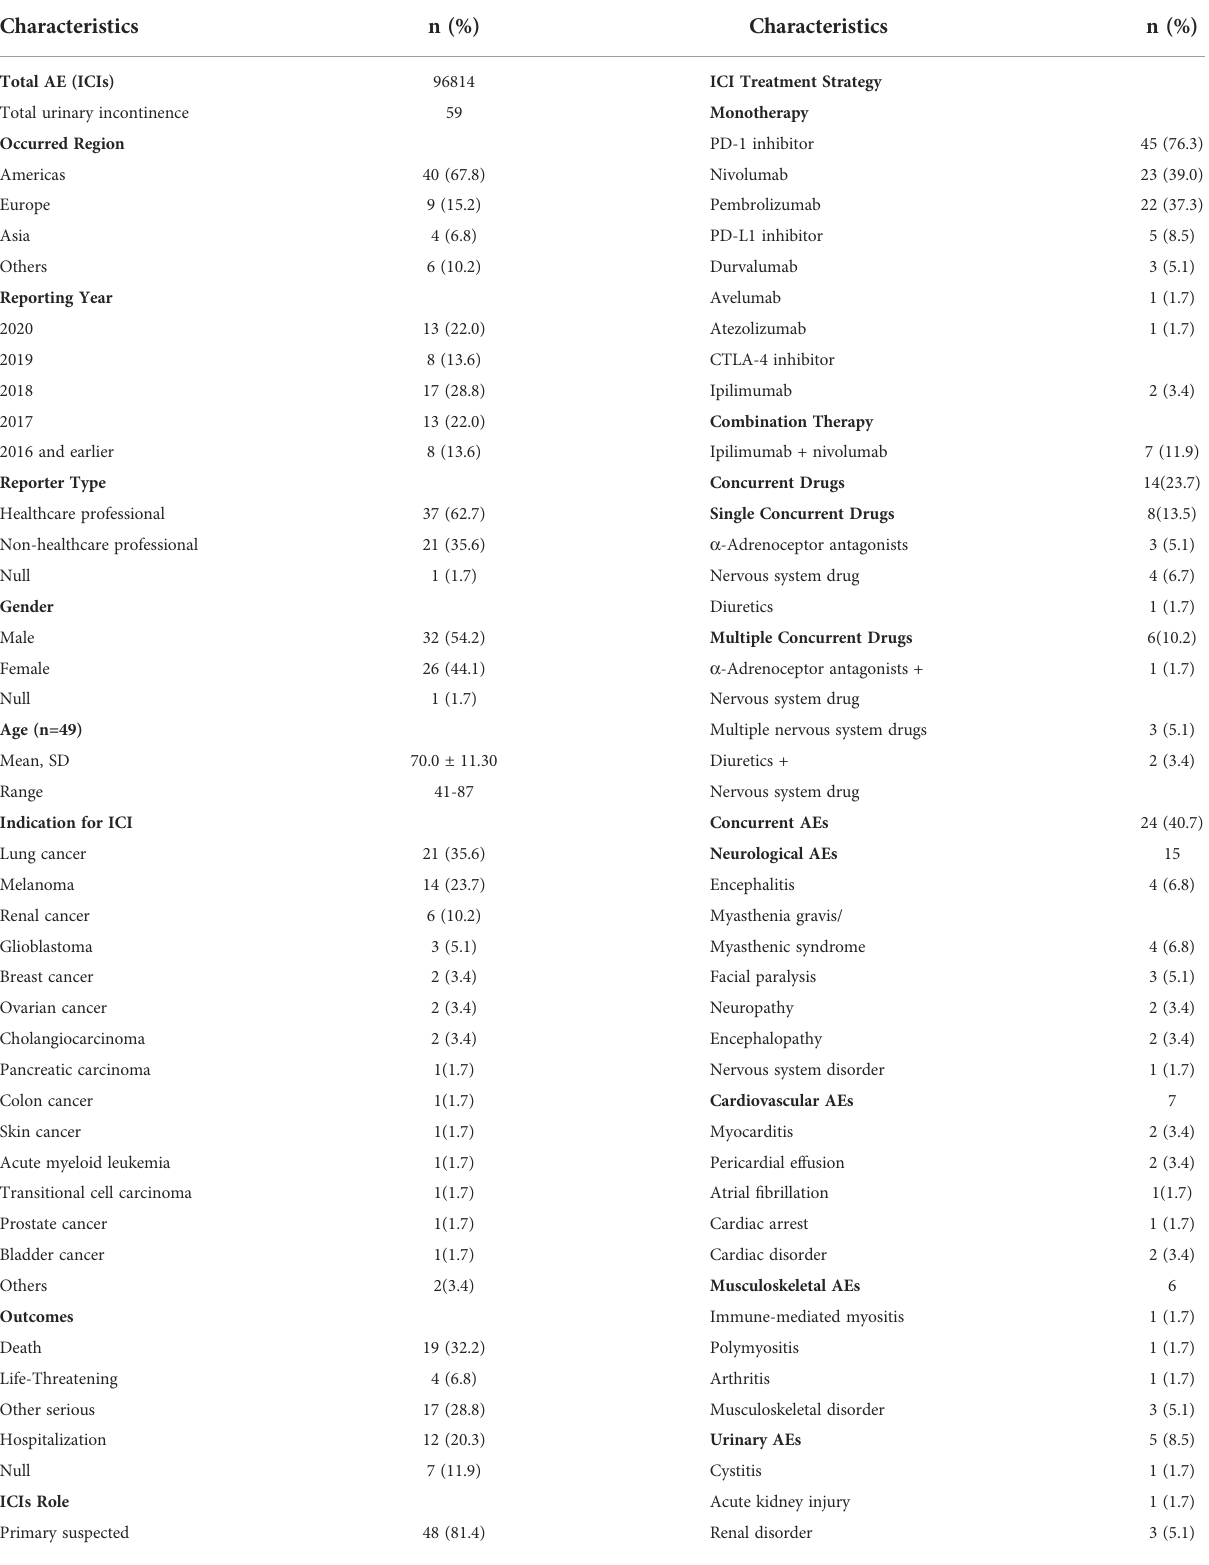
TABLE 1 The characteristics of patients with immune checkpoint inhibitor (ICI) – related urinary incontinence.